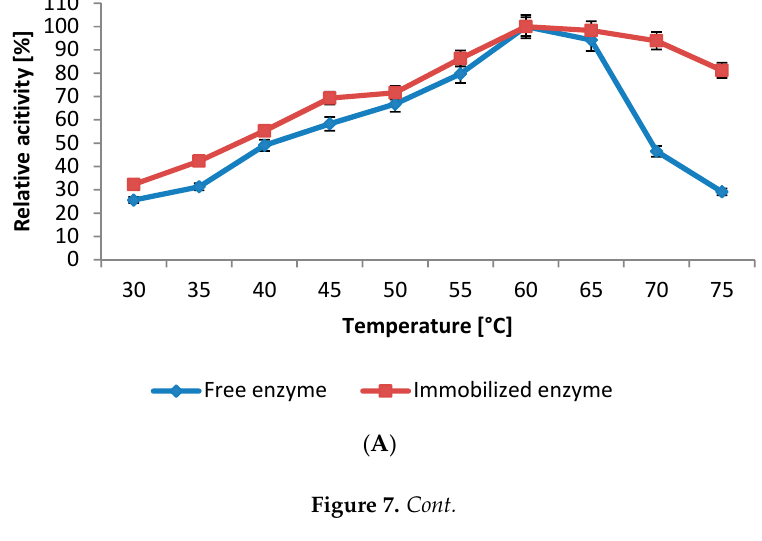
( A ) ( A ) Figure 7. Cont. Figure 7. Figure 7. Cont.